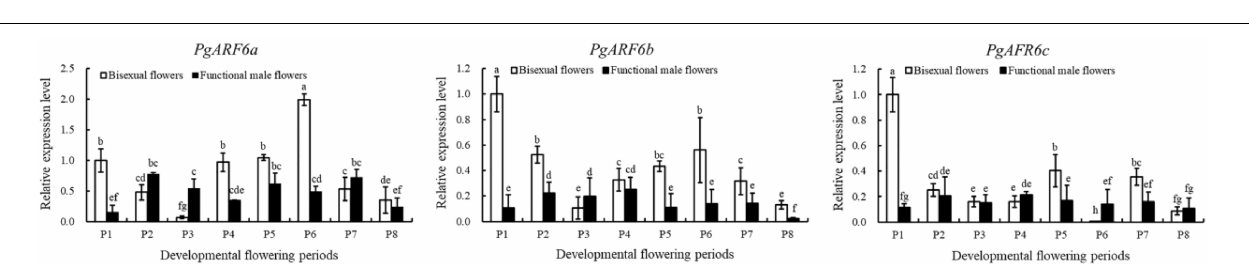
FIGURE 9 | Endogenous hormone in pomegranate flowers under 6-BA treatment.